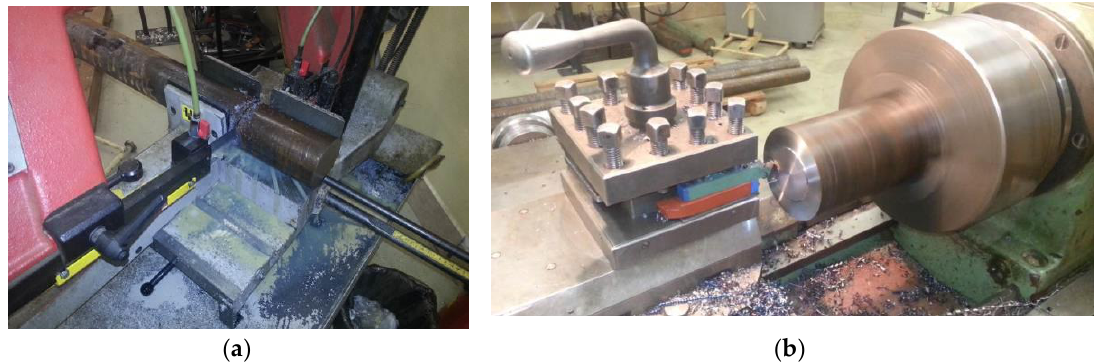
Figure 8. Carrying out of experiments – material cutting ( a ), face alignment ( b ).